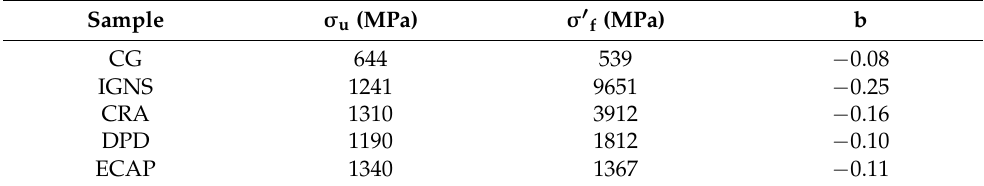
Table 2. Mechanical and derived fatigue parameters of CG, IGNS, and CRA samples according to Equation (1) in comparison with those obtained in dynamic plastic deformation (DPD), data from [38] and equal channel angular pression (ECAP), data from